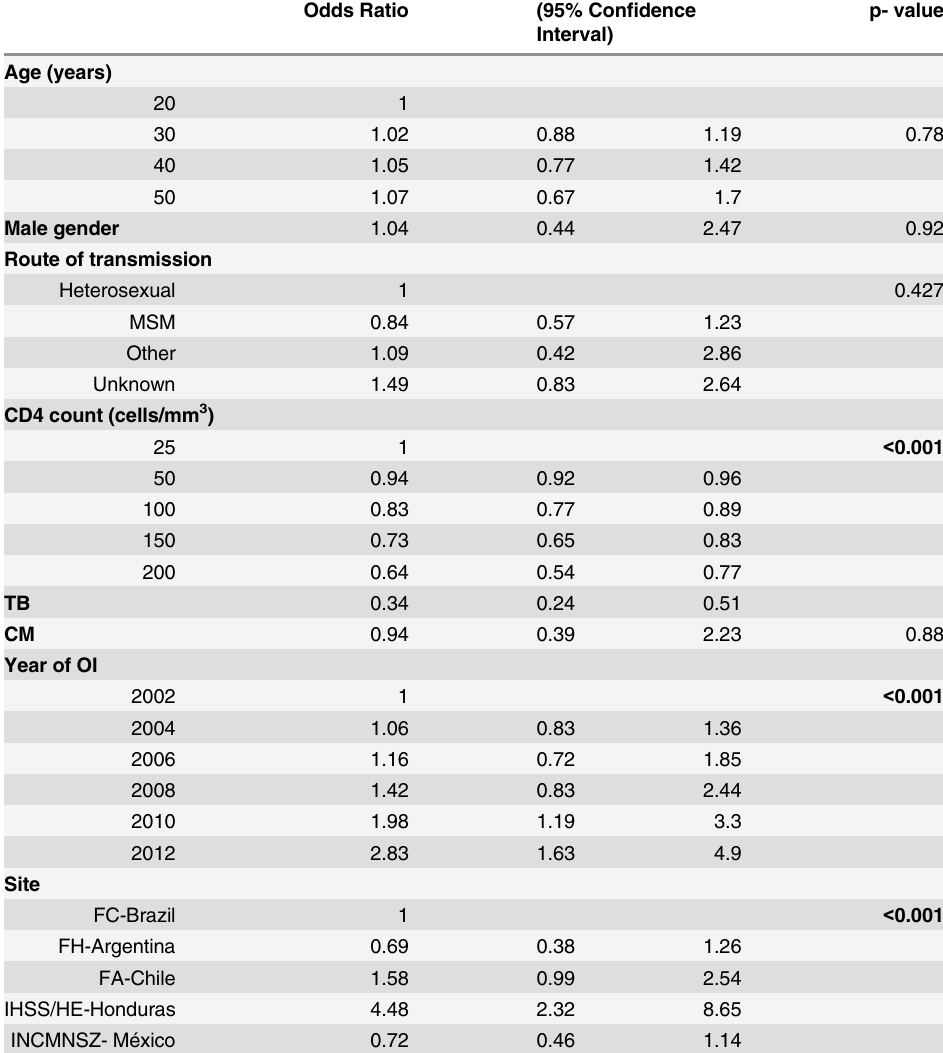
MSM = Men who have sex with men; TB = tuberculosis; CM = cryptoccocal meningitis; OI = opportunistic